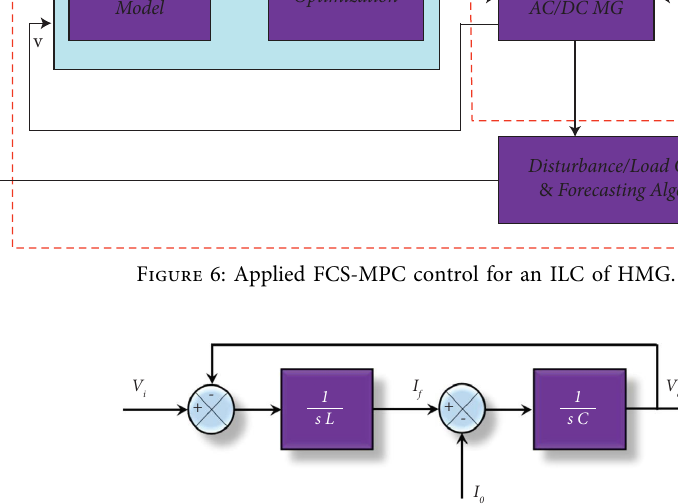
Figure 7: Filter model for predictive voltage control.